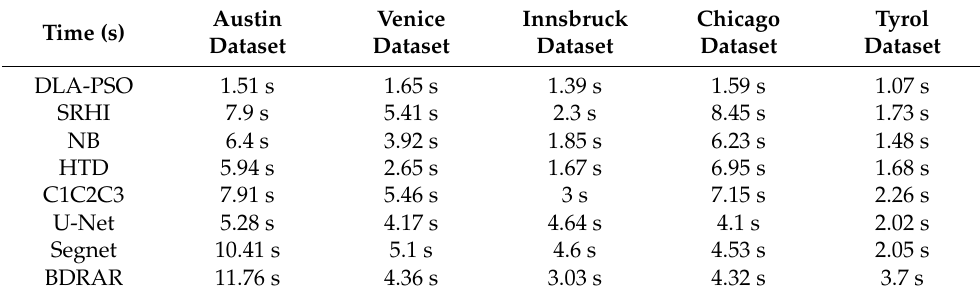
Table 10. The comparison of average computing times on different urban datasets. Time (s)